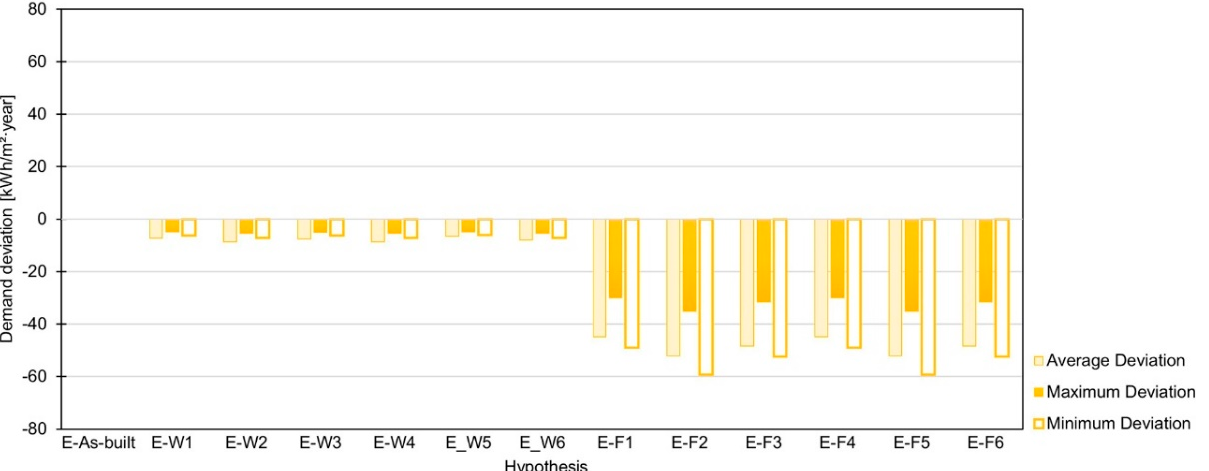
Figure 13. Annual thermal demand per m² of the hypothesis (average values of the different orien- tation models per hypothesis).